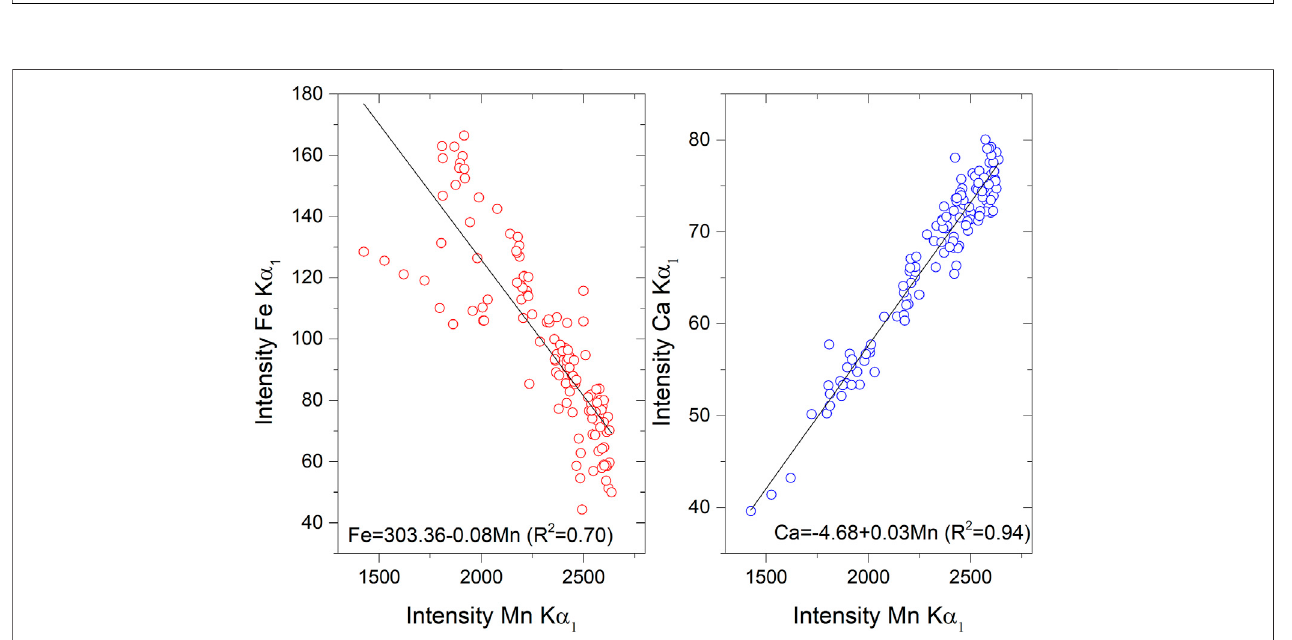
FIGURE 8 | Scatter plot of the abundances of Mn, Fe, and Ca measured along the μ XRF scan pro fi le (see Figure 2 ).